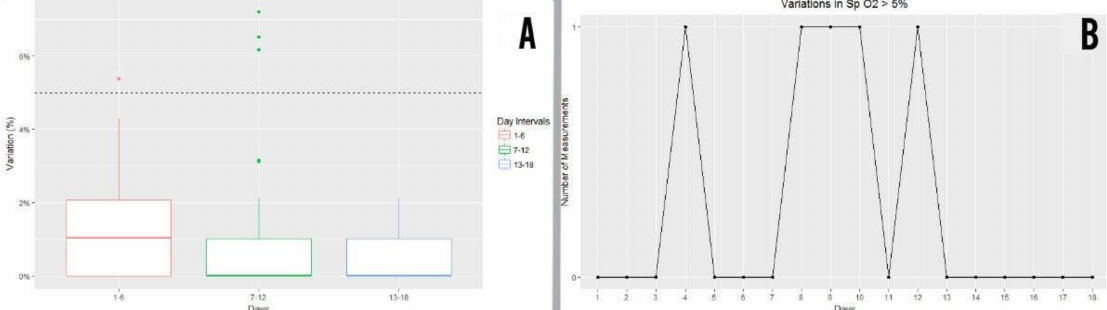
Figure 12. ( A )Results of daily variations in blood oxygen saturation (SpO2) for the study group during exercise, grouped together into 6-day intervals. ( B ) Number of blood oxygen saturation measurements which were above the cut-off point per